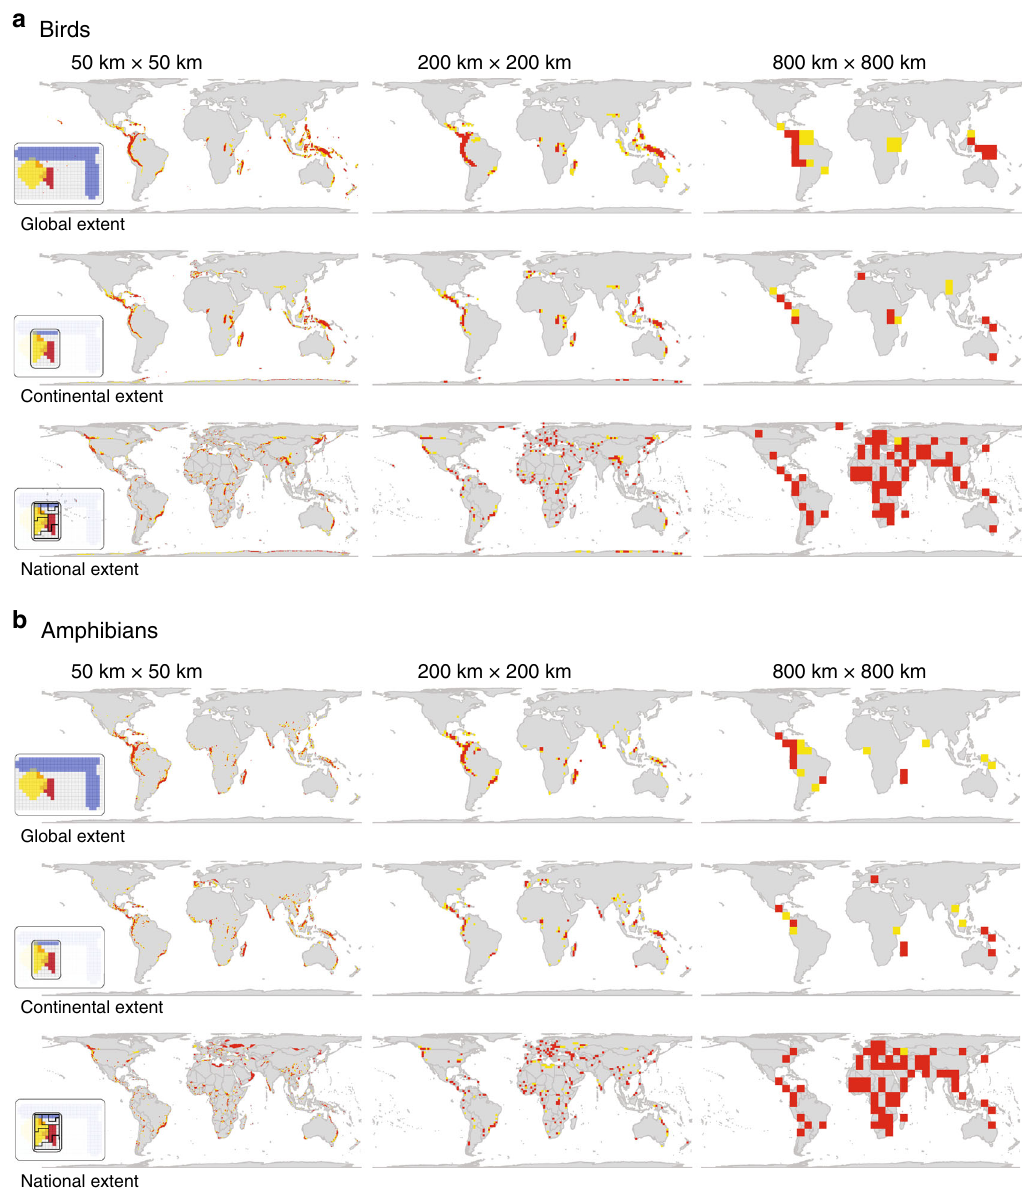
Fig. 3 Hotspots of phylogenetic endemism (geographic concentrations of phylogenetically and geographically restricted species) are in fl uenced strongly by spatial extent, varying along global, continental and national extents at country level. a Birds ( n = 10,018 species), and b amphibians ( n = 5872 species) of the world across three levels of spatial extents (global, continental and national). Global patterns of phylogenetic endemism re fl ect complex evolutionary processes but are lost at the continental to country extents. When extent is varied, we are varying the scale at which phylogenetic endemism is calculated. Also pictured, on the left in the inset, are simpli fi ed visual illustrations of how extent is calculated. Hotspots were identi fi ed using the 2.5% threshold based on the 97.5 th percentile values for phylogenetic endemism per grid cell (indicated in red), and 5% corresponding to 95 th percentile values (indicated in yellow). The maps are in Behrmann projection. See Supplementary Fig. 3 for full variation of phylogenetic endemism across grid cells at 50, 100, 200, 400 and 800km. Source data are provided as a Source Data fi